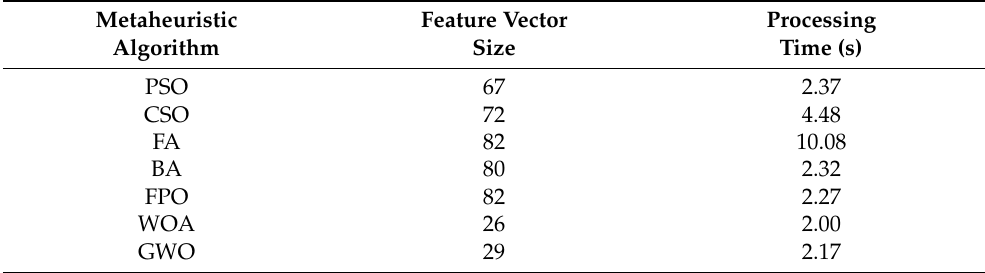
Table 5. Average feature vector size and processing time of the optimization algorithms.